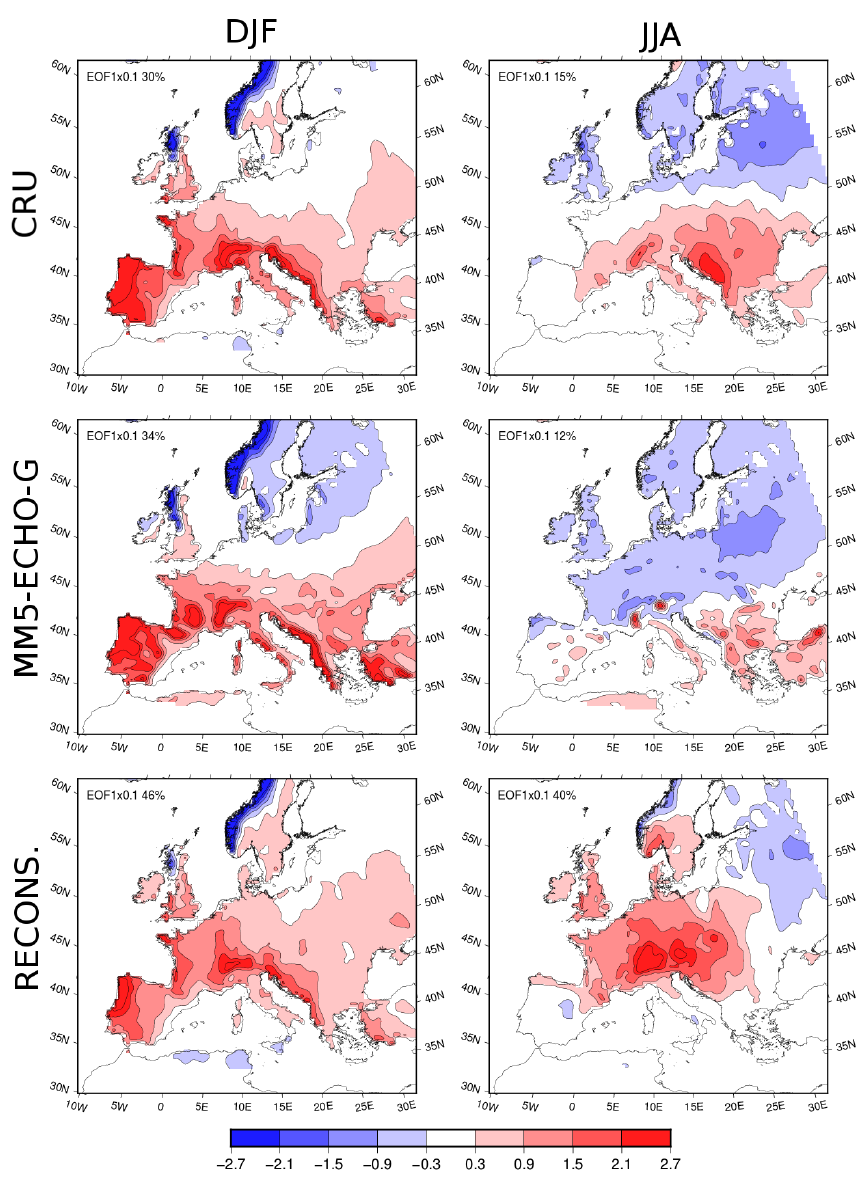
Figure 9. As Fig. 8 but for PRE. The units are millimetres per